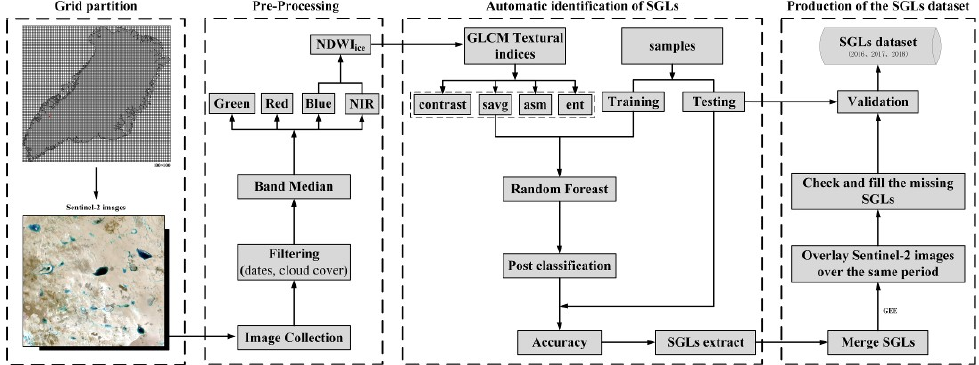
Figure 2. Workflow chart of SGLs extraction in GEE. (Near Infrared (NIR); the feature variables of GLCM that contrast, savg, asm, and ent, are described in Section 3.2).